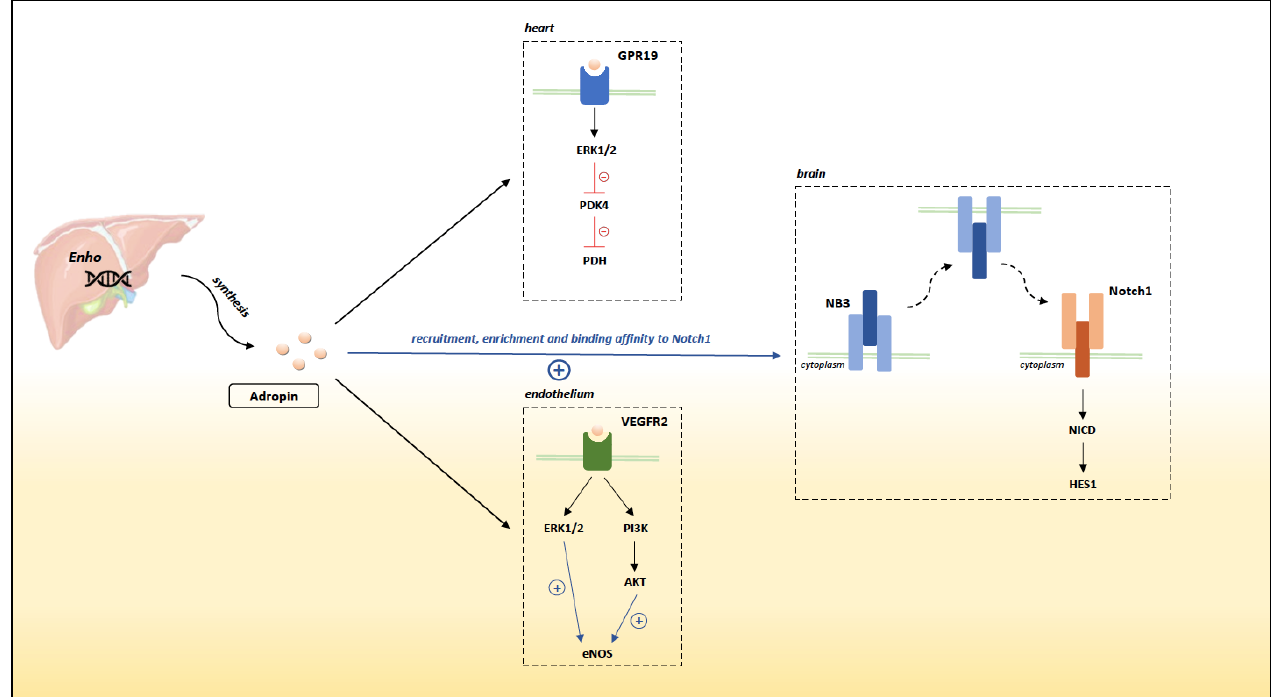
Figure 1. Receptors for adropin in different tissues. The blue “+” indicates stimulation, whereas red “−“ indicates inhibition. Abbreviations: GPR19: G-protein coupled receptor 19; VEGFR2: Vascular endothelial growth factor receptor 2; ERK 1/2: extracellular signal-regulated kinase 1/2; PI3K: Phosphoinositide 3-kinase; PDK4: pyruvate dehydrogenase kinase 4; PDH: pyruvate dehydrogenase; AKT: protein kinase B; NICD: intracellular domain of Notch; HES1: hairy and enhancer of split-1.